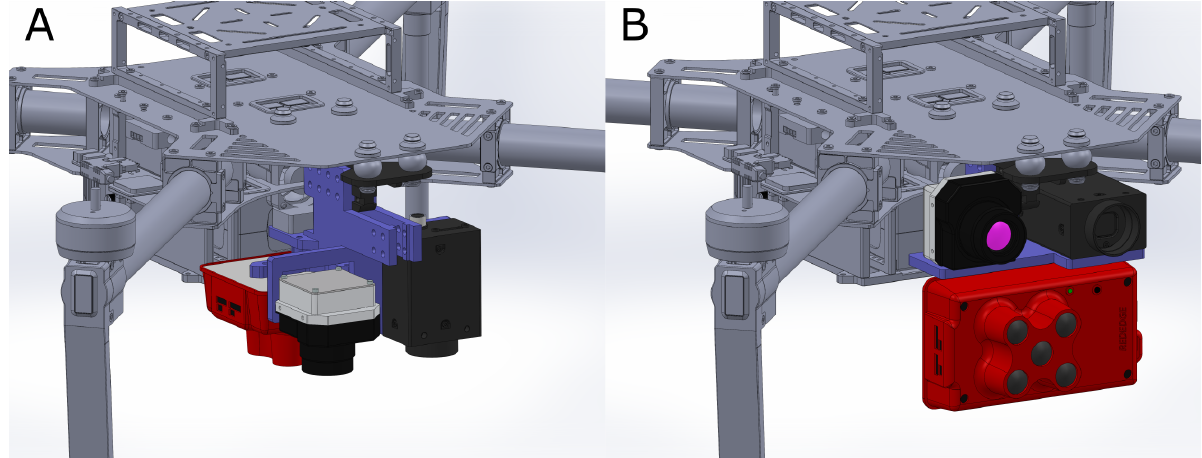
Figure 3. RGB, multispectral and thermal cameras mounted on a low-payload UAV (Matrice 100, DJI, China). ( A ) Vertical mounting. ( B ) Horizontal mounting.